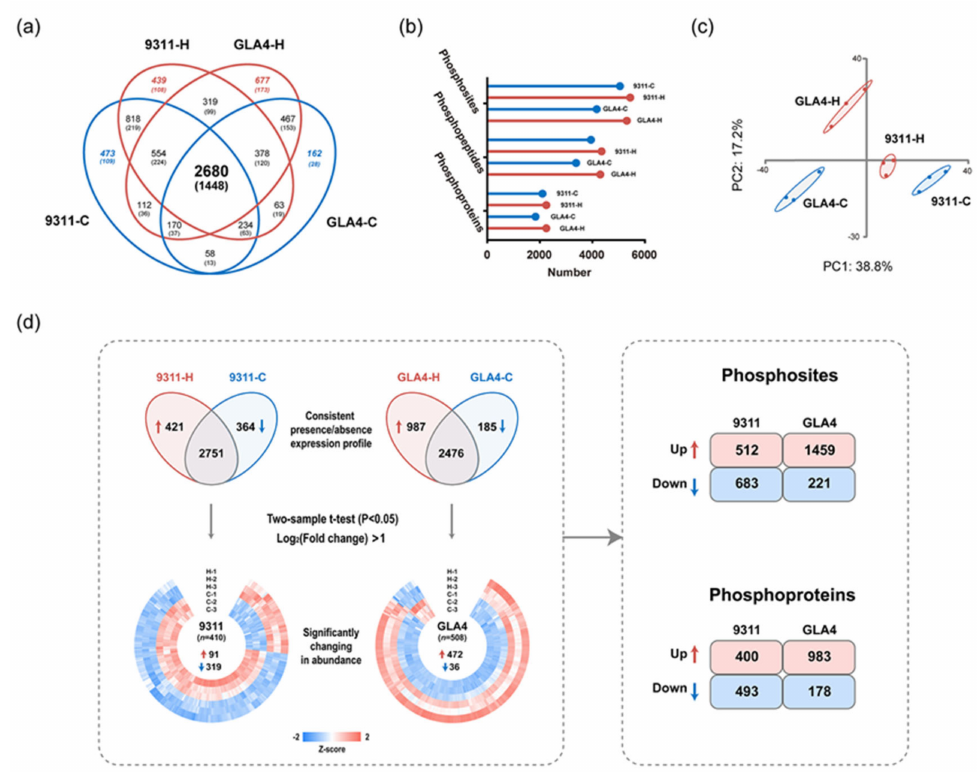
Figure 3. A temperature regulated rice endosperm phosphoproteome. ( a ) Venn diagram depicting the comparison of phos- phosites (phosphoproteins) from four sample groups. ( b ) Number of phosphosites, phosphopeptides, and phosphoproteins detected in 9311-C, 9311-H, GLA4-C, and GLA4-H. ( c ) Principal component analysis (PCA) based on phosphorylation intensity across all four sample groups with three biological repetitions. ( d ) Differentially expression profiles of phosphosites (phosphoproteins) in 9311 and GLA4 under high-temperature stress. The expression profiles of selected phosphosites ( p < 0.05, log 2 (fold change) >1) were normalized using the Z-score and presented in a heatmap. In each variety, phosphosites (phosphoproteins) with a consistent presence/absence expression pattern and significantly regulated from the statistical test were combined for subsequent comparative